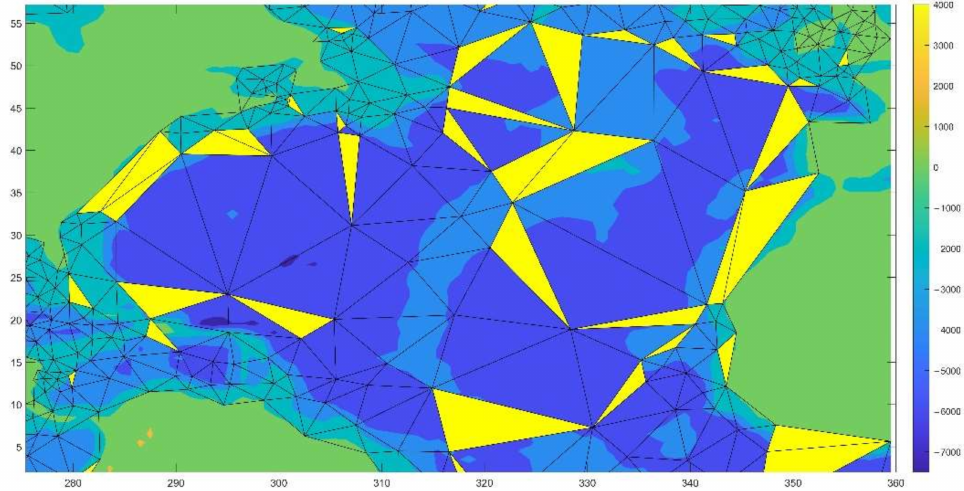
Figure 8. Selected unstructured grid of small area of the North Atlantic Ocean to be optimized. Step 2~Step 3 were the same as Step 4~Step 5 in Section